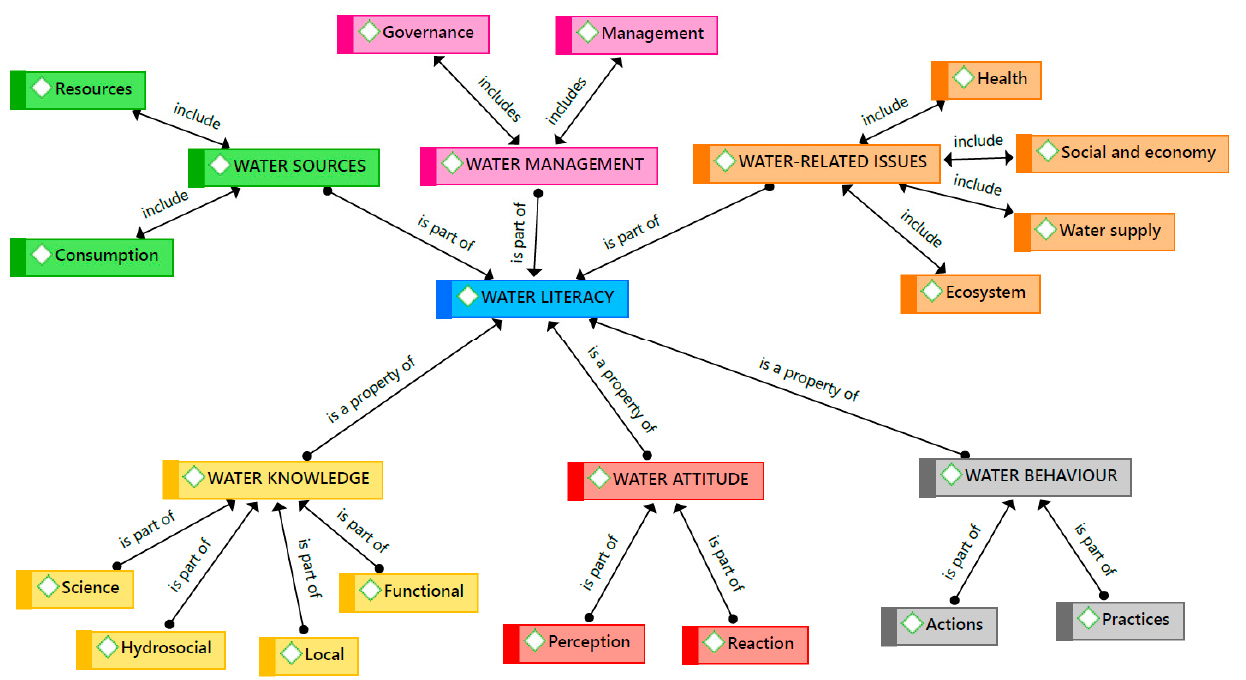
Figure 1. Different components of water literacy include water sources, water management, water related issues, water knowledge, water attitude and water behavior.